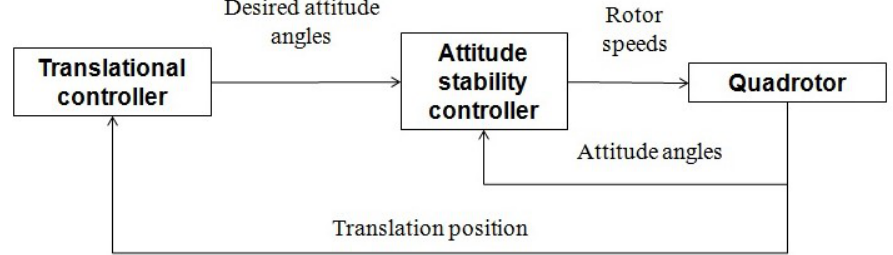
Figure 4. Control system for each UAV in the